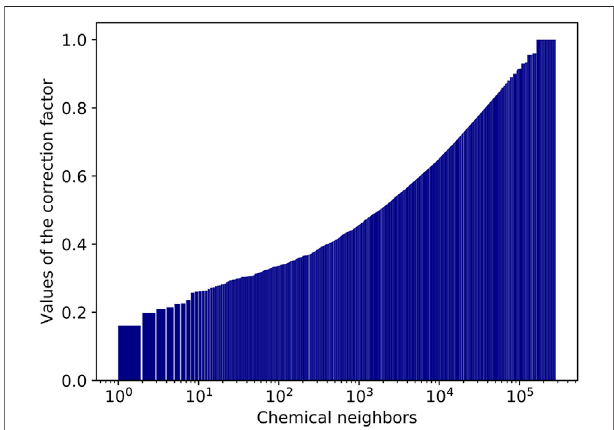
FIGURE 9 | Values of the correction factor ϑ j for chemical